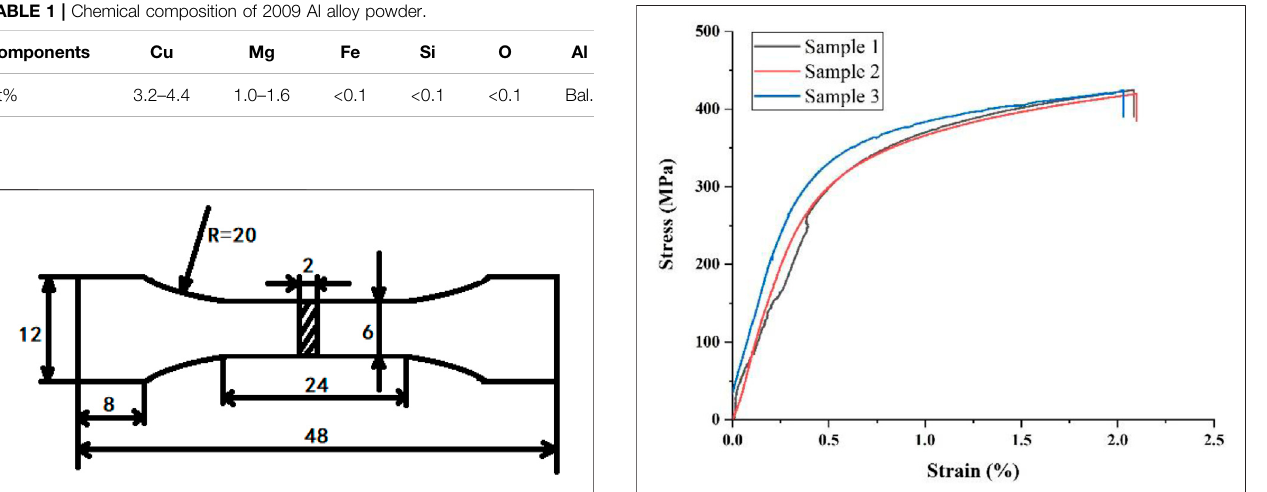
FIGURE 1 | Geometric dimension of the specimen (Unit: mm).